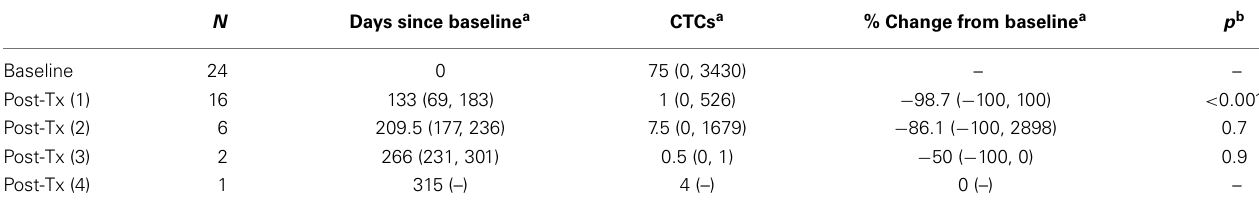
Table 2 | Circulating tumor cells detection .